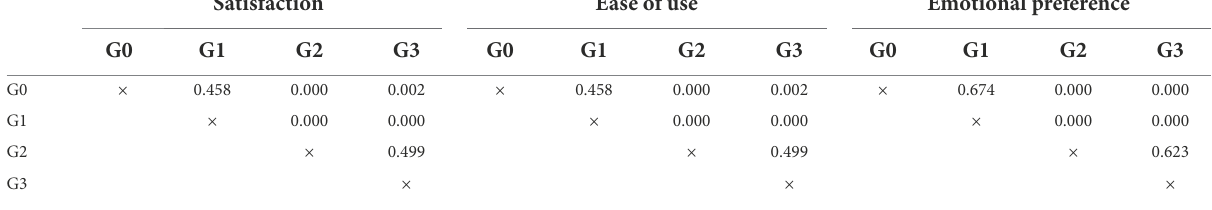
TABLE 13 One-way ANOVA test of subjective preference with different layout methods. Satisfaction Ease of